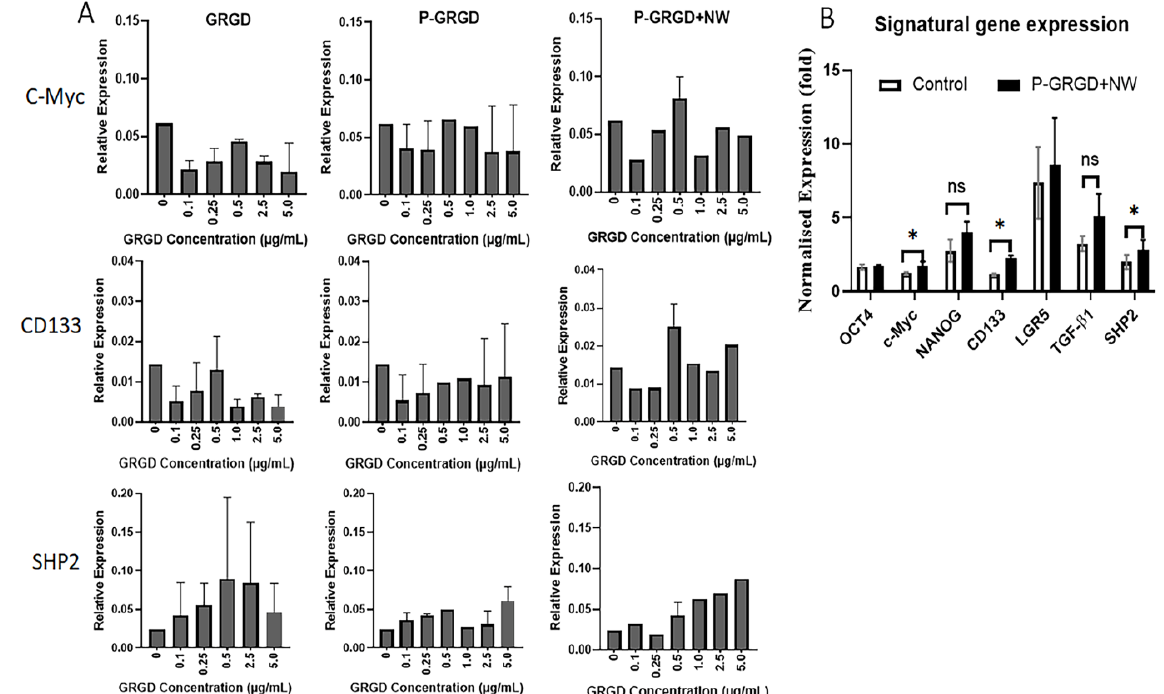
Figure 4. Influence of P-GRGD+NW treatment on expression of stem genes in colon cancer cells. ( A ) the real-time RT-PCR measurement of the featural cancer stem gene expressions, including C-Myc, CD133 and SHP2 after seven days sphere culture of HCT116 and treatment with different doses of GRGD, P-GRGD, and P-GRGD+NW. ( B ) some important stem gene expressions by qPCR measurement after seven days treatment with the optimised condition of 0.5 µg/mL P-GRGD plus 5 µg/mL NW in HCT116 cells. Notes: ns: P > 0.05; *: P < 0.05.